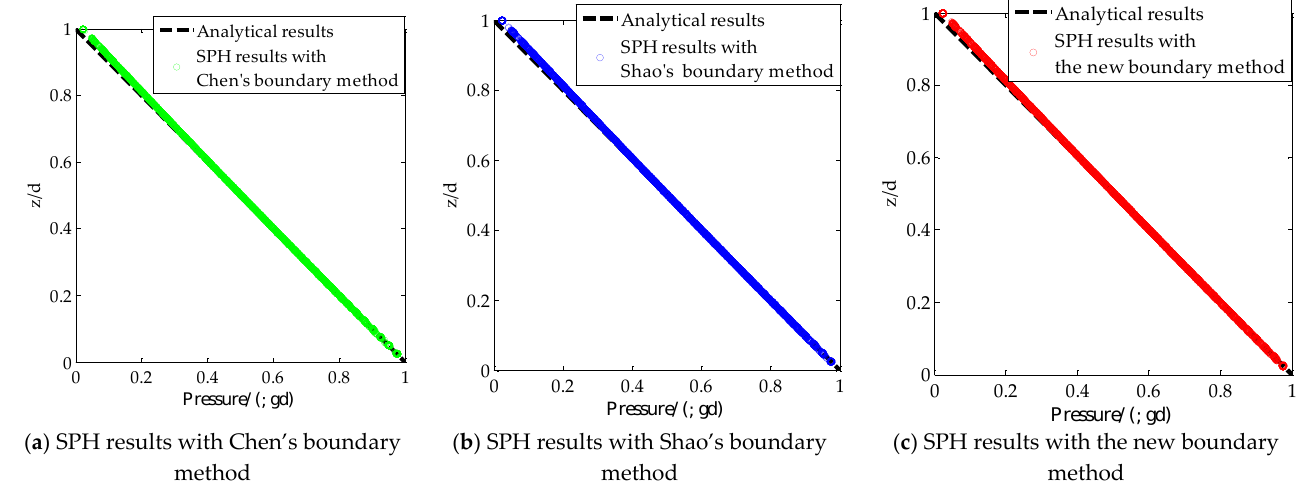
Figure 4. Comparisons of particle pressure values versus depth obtained by SPH simulations with different boundary methods at 15.0: ( a ) SPH results with Chen’s boundary method; ( b ) SPH results with Shao’s boundary method; ( c ) SPH results with the new boundary method.